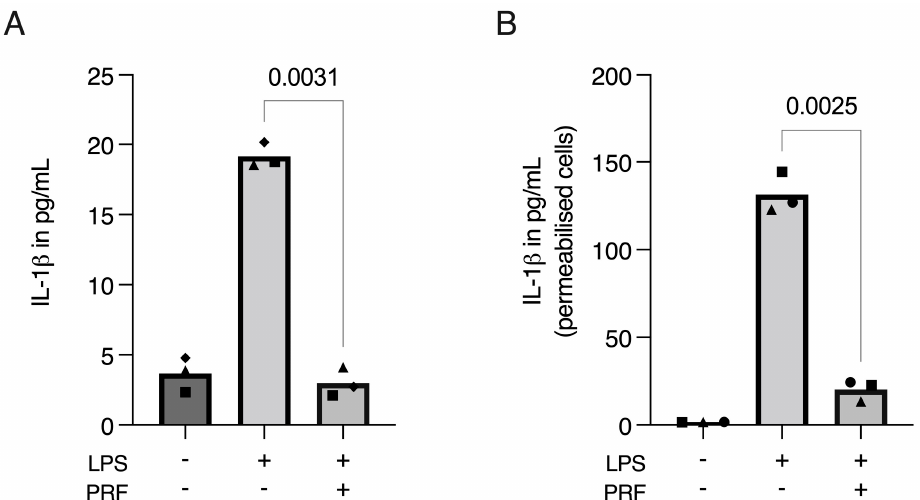
Figure 5. PRF moderates the release of IL-1 β in LPS-induced RAW 264.7 macrophages. A significant reduction in IL-1 β in LPS-induced RAW 264.7 macrophages was found on cell supernatants ( A ), which was boosted and reproduced when the cell membranes were permeabilised with Triton X-100 ( B ), showing that IL-1 β was produced, but not released, to the extracellular media following the LPS challenging on RAW 264.7 macrophages. Each data point represents an independent experiment. n = 3. To compare groups, paired t -test was